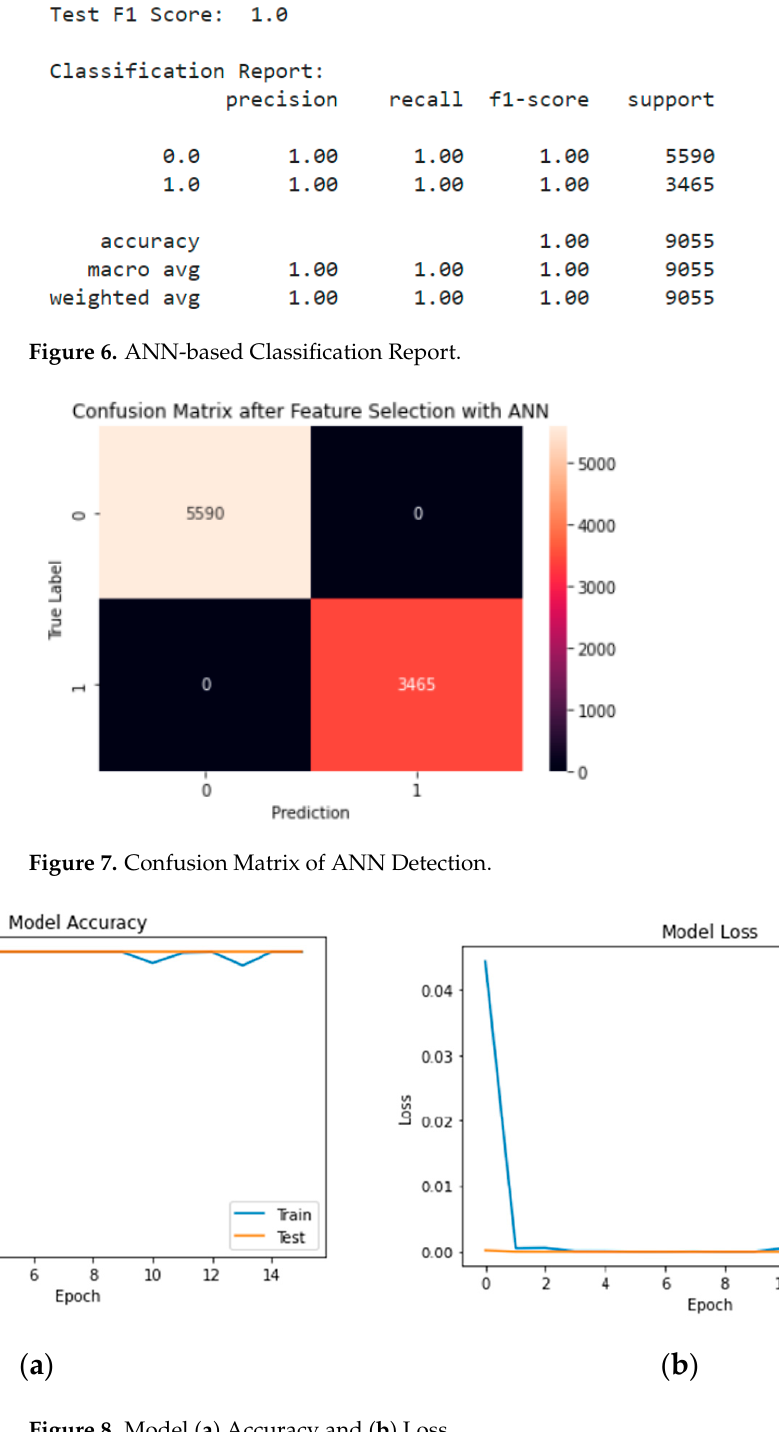
Figure 8. Model ( a ) Accuracy and ( b ) Loss.